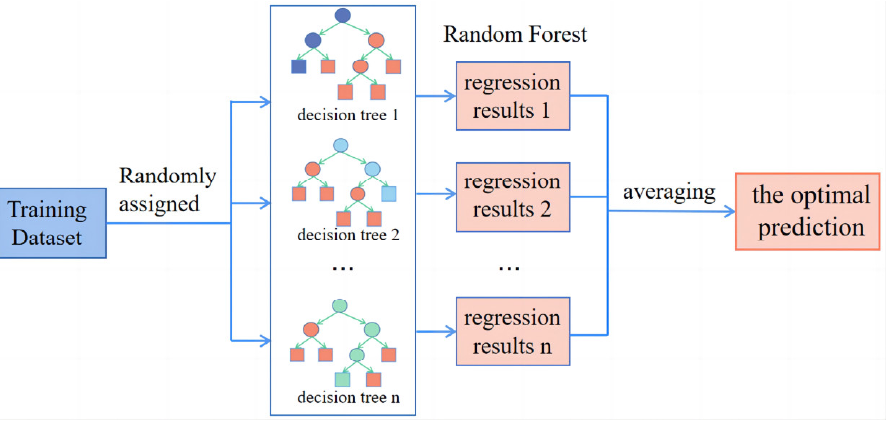
Figure 6. RF modeling flowchart.